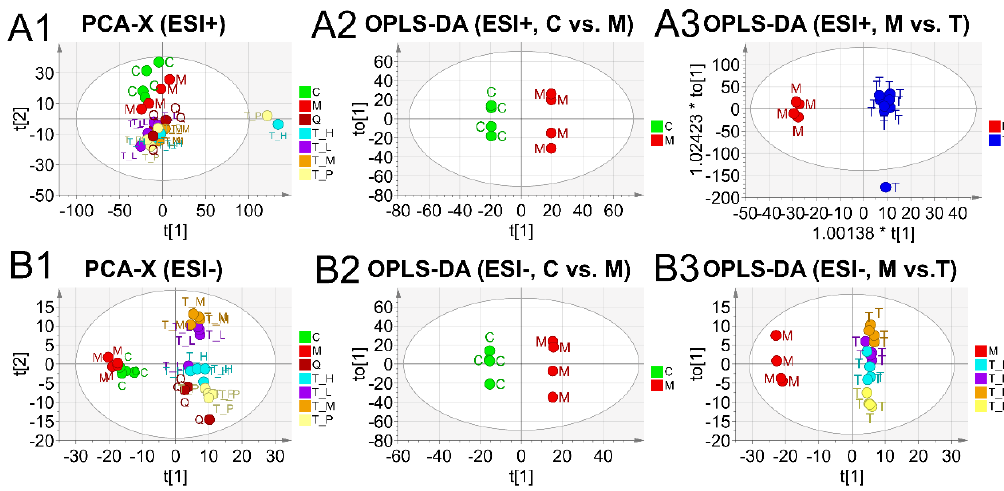
Figure 9. Multivariate analysis results of Ultra-Performance Liquid Chromatography-Mass Spectrometry (UPLC-MS). Principle Component Analysis (PCA) and orthogonal projections to latent structures discriminant analysis (OPLS-DA) models were displayed as two-dimensional plots. PCA of all samples in electrospray ionization in positive (ESI+) mode ( A1 ) and in electrospray ionization in negative (ESI − ) mode ( B1 ) (PC1 = 51.1%, PC2 = 8.25% for ESI+ and PC1 = 28%, PC2 = 11.6% for ESI − ). The OPLS-DA discrimination score plots between different groups: ( A2 ) Control vs. Model in ESI+, p < 0.00001; ( A3 ) Model vs. Treatment groups in ESI+, p = 0.015; ( B2 ) Control vs. Model in ESI − , p < 0.00001; ( B3 ) Model vs. Treatment groups in ESI − , p < 0.0001. Control was abbreviated as C, Model as M, Treatment with low, middle, high dosage as T_L, T_M and T_H respectively. Treatment with positive DCS as T_P, QC as Q. In PCA, t [1] are the first variables summarized from the original data and t [2] are the second ones. In OPLS-DA, t [1] is the predictive X-scores and to [1] is the Orthogonal X-scores. All p values were estimated with CV-ANOVA test. * in A3 means the multiple magnification to the coordinate axes.